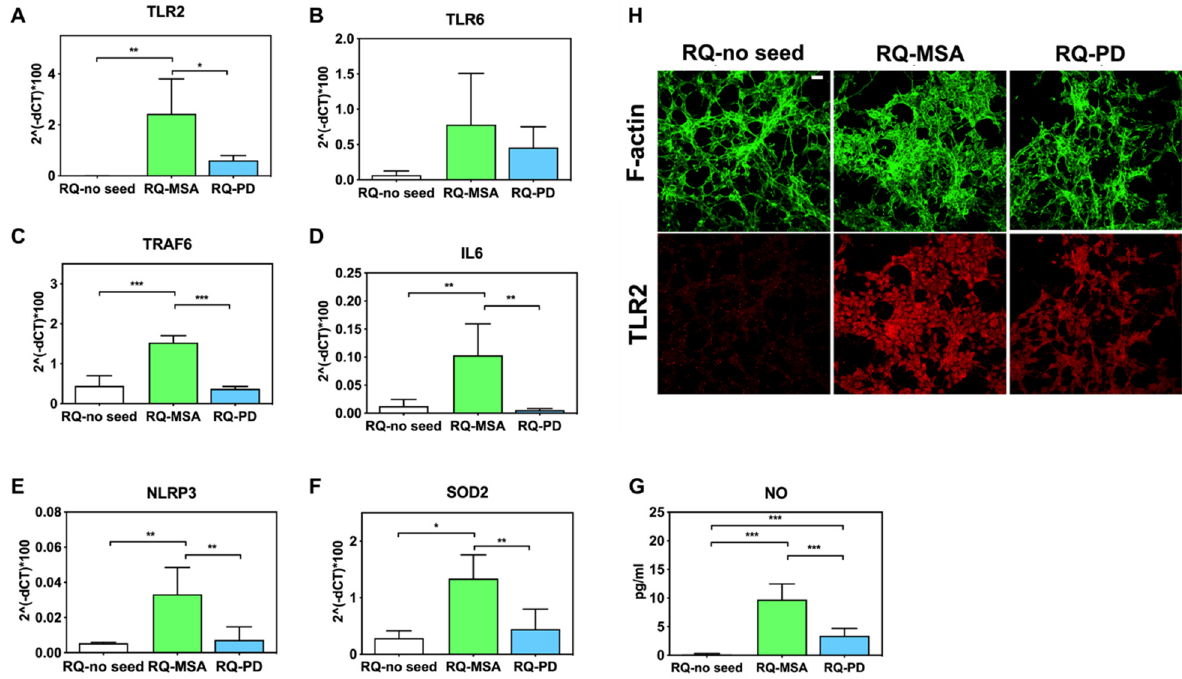
Figure 3. Analysis of inflammatory molecules in differentiated SH-SY5Y cells stimulated with RQ-MSA, RQ-PD and RQ-no seed. RT-qPCR analysis of TLR2 ( A ), TLR6 ( B ), TRAF6 ( C ), IL6 ( D ), NLRP3 ( E ), SOD2 ( F ) transcripts in SH-SY5Y exposed to RQ-MSA, RQ-PD (2.5 µM), and RQ-no seed for 24 h (mean ± SD). ( G ) NO release (mean ± SD) quantification through Griess’ reaction in the supernatants of cells stimulated with RQ-MSA, RQ-PD and RQ-no seed. Statistical significance was assessed by one-way ANOVA test with Dunnett’s multiple comparison test. Corrected p -values are reported in the results section. * p ≤ 0.05, ** p ≤ 0.01, *** p ≤ 0.001. ( H ) Confocal microscopy analysis showed increased TLR2 expression (red) in SH-SY5Y exposed to RQ-MSA and RQ-PD. Counterstaining with Alexa-Fluor 488-Phalloidin (green) was performed to monitor the cytoskeleton structure that appeared preserved in all experimental conditions. Scale bar = 25 µm.